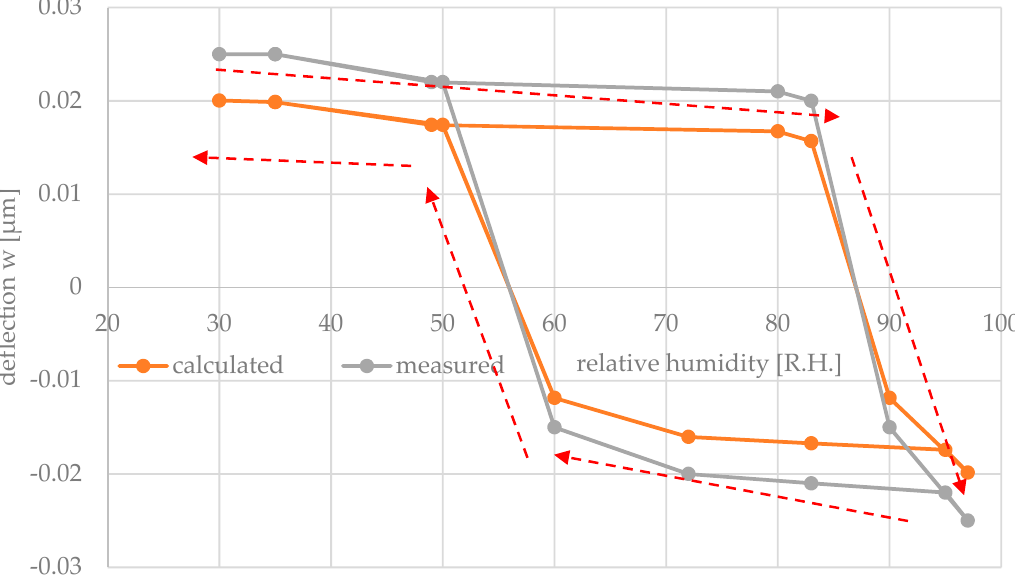
Figure 16. Measured and calculated deflection of a bending plate partly covered with an SiO 2 -layer and a hydrogel layer as a function of the relative humidity, with the pre-deflection angle ϕ 0 = 0.00057.